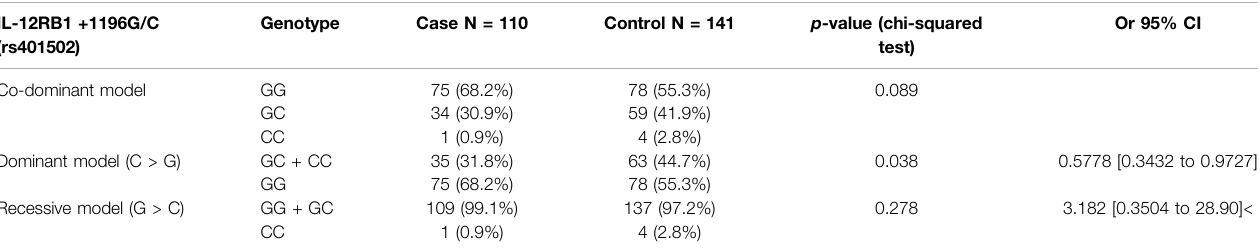
TABLE 3 | Allelic and genotypic distributions of the IL12RB1 +1196G/C (rs401502) polymorphism in patients with CRC and controls. IL-12RB1 +1196G/C (rs401502)